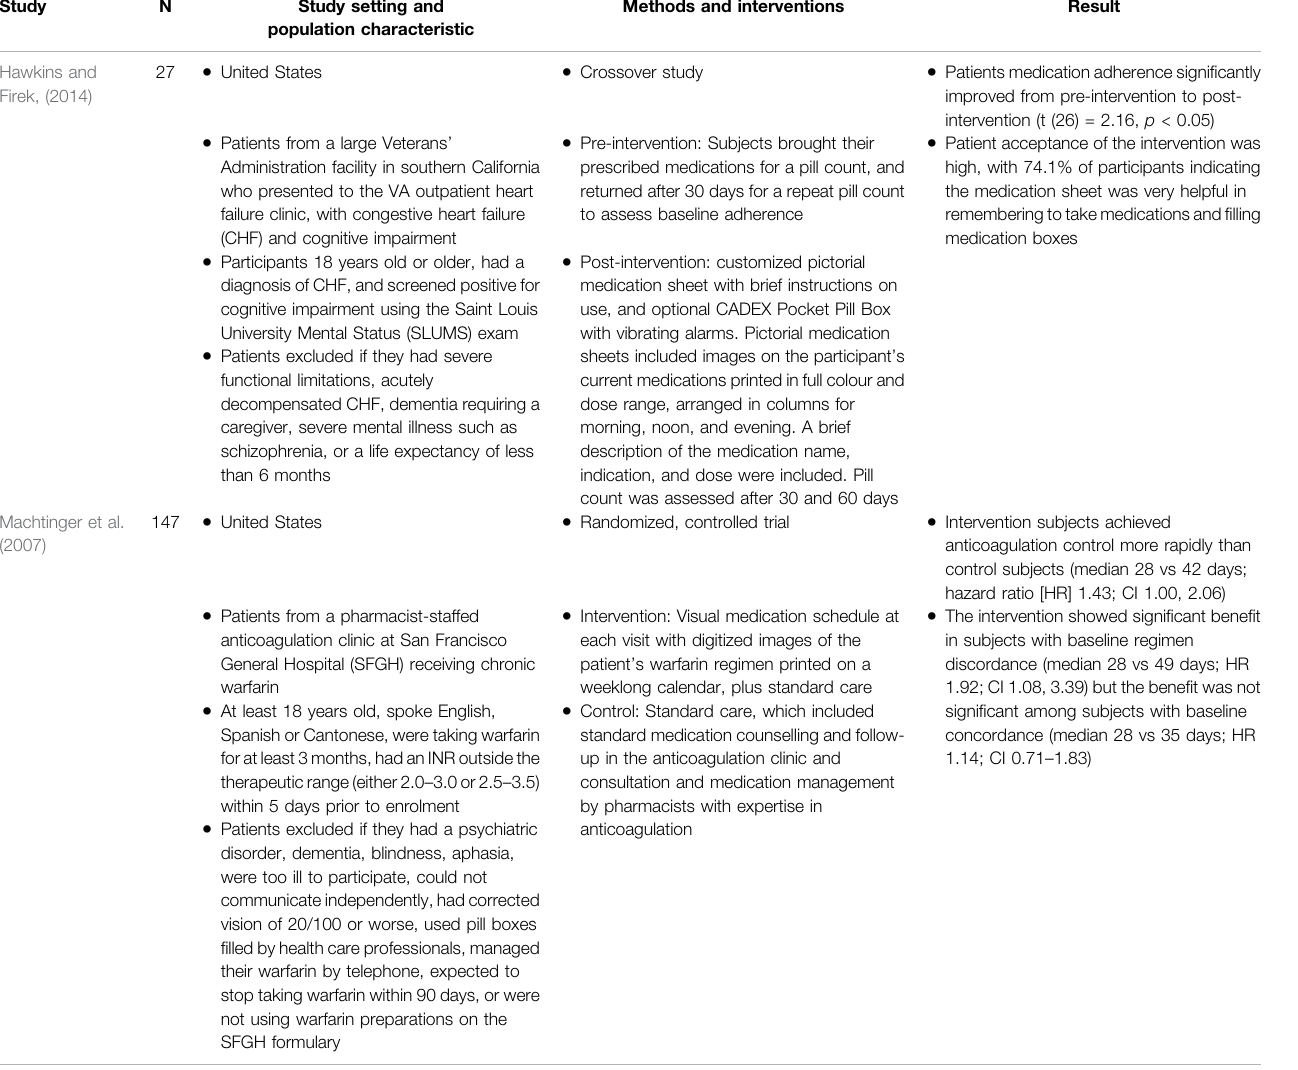
TABLE 1 | ( Continued ) Pictograms in the pharmaceutical care of chronically ill